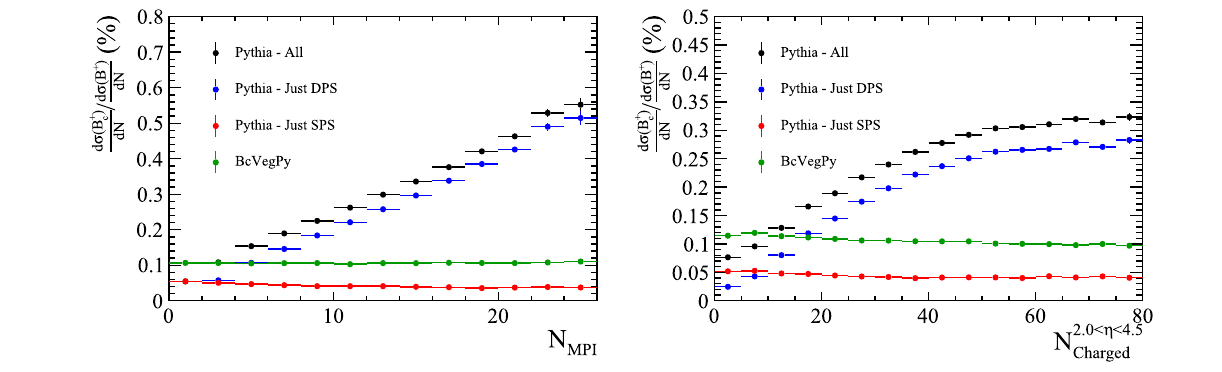
Table 4 Pythia generation settings used to simulate the samples of (cid:2)